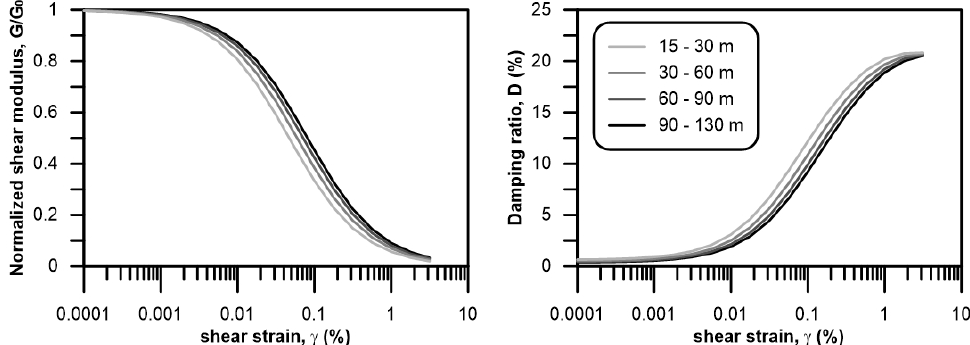
Figure 16. Normalized shear modulus and damping ratio curves adopted for deeper (>15 m) soil layers [91].